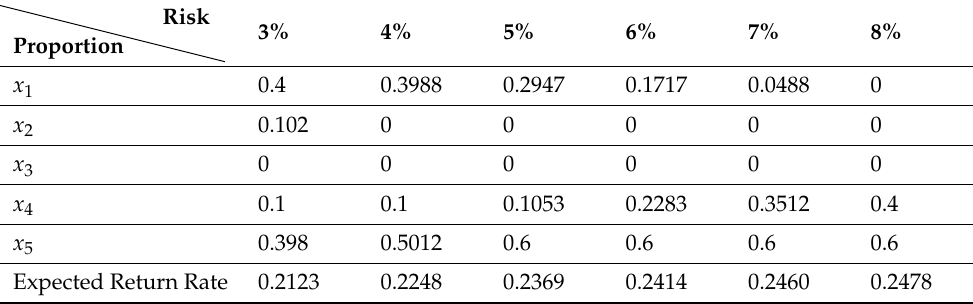
Table 2. An efficient portfolio with a guaranteed return rate (cid:101) p 2